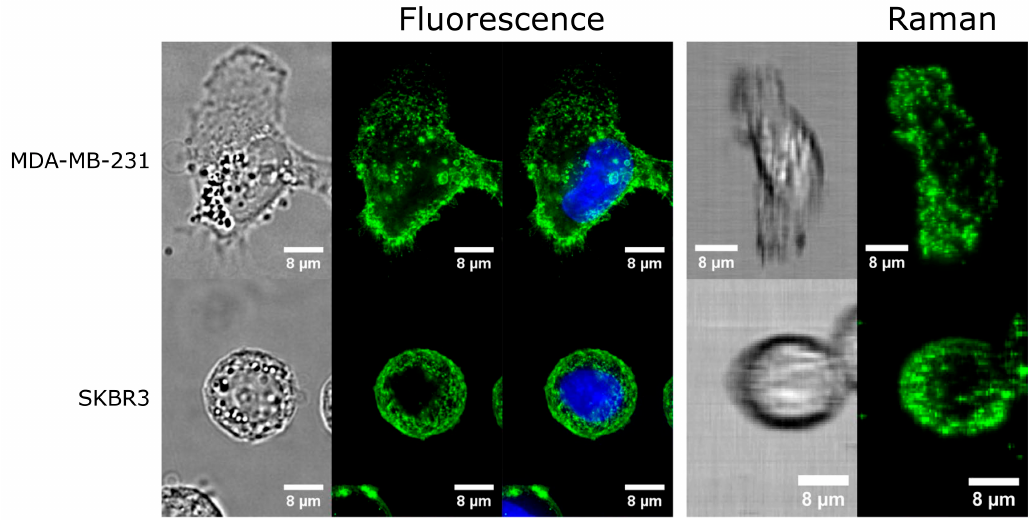
Figure 5. Comparison of Surface-Enhanced Raman Scattering (SERS) and fluorescence images. Top : Fluorescence and Raman images of MDA-MB-231 cells stained with CD44 fluorescence and SERS conjugates, respectively. Bottom : Fluorescence and Raman images of SKBR3 cells stained with HER2 fluorescence and SERS conjugates, respectively. All images are accompanied by brightfield images for reference. Blue indicates the nuclei of the cells. Scale bars are 8 μ m. Reproduced from reference [88].